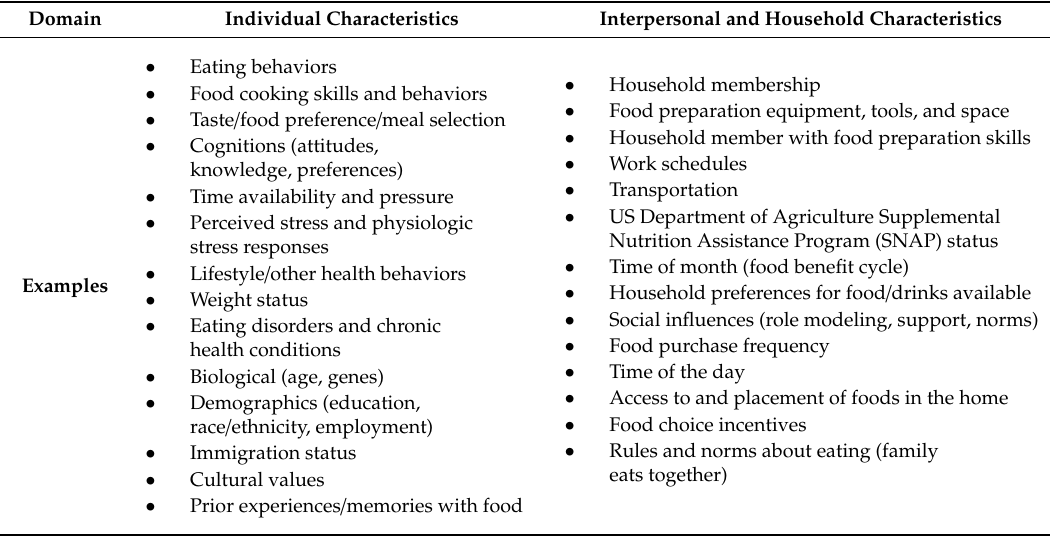
Table 2. Examples of individual, interpersonal, and household characteristics relevant to food and beverage purchasing and dietary intake